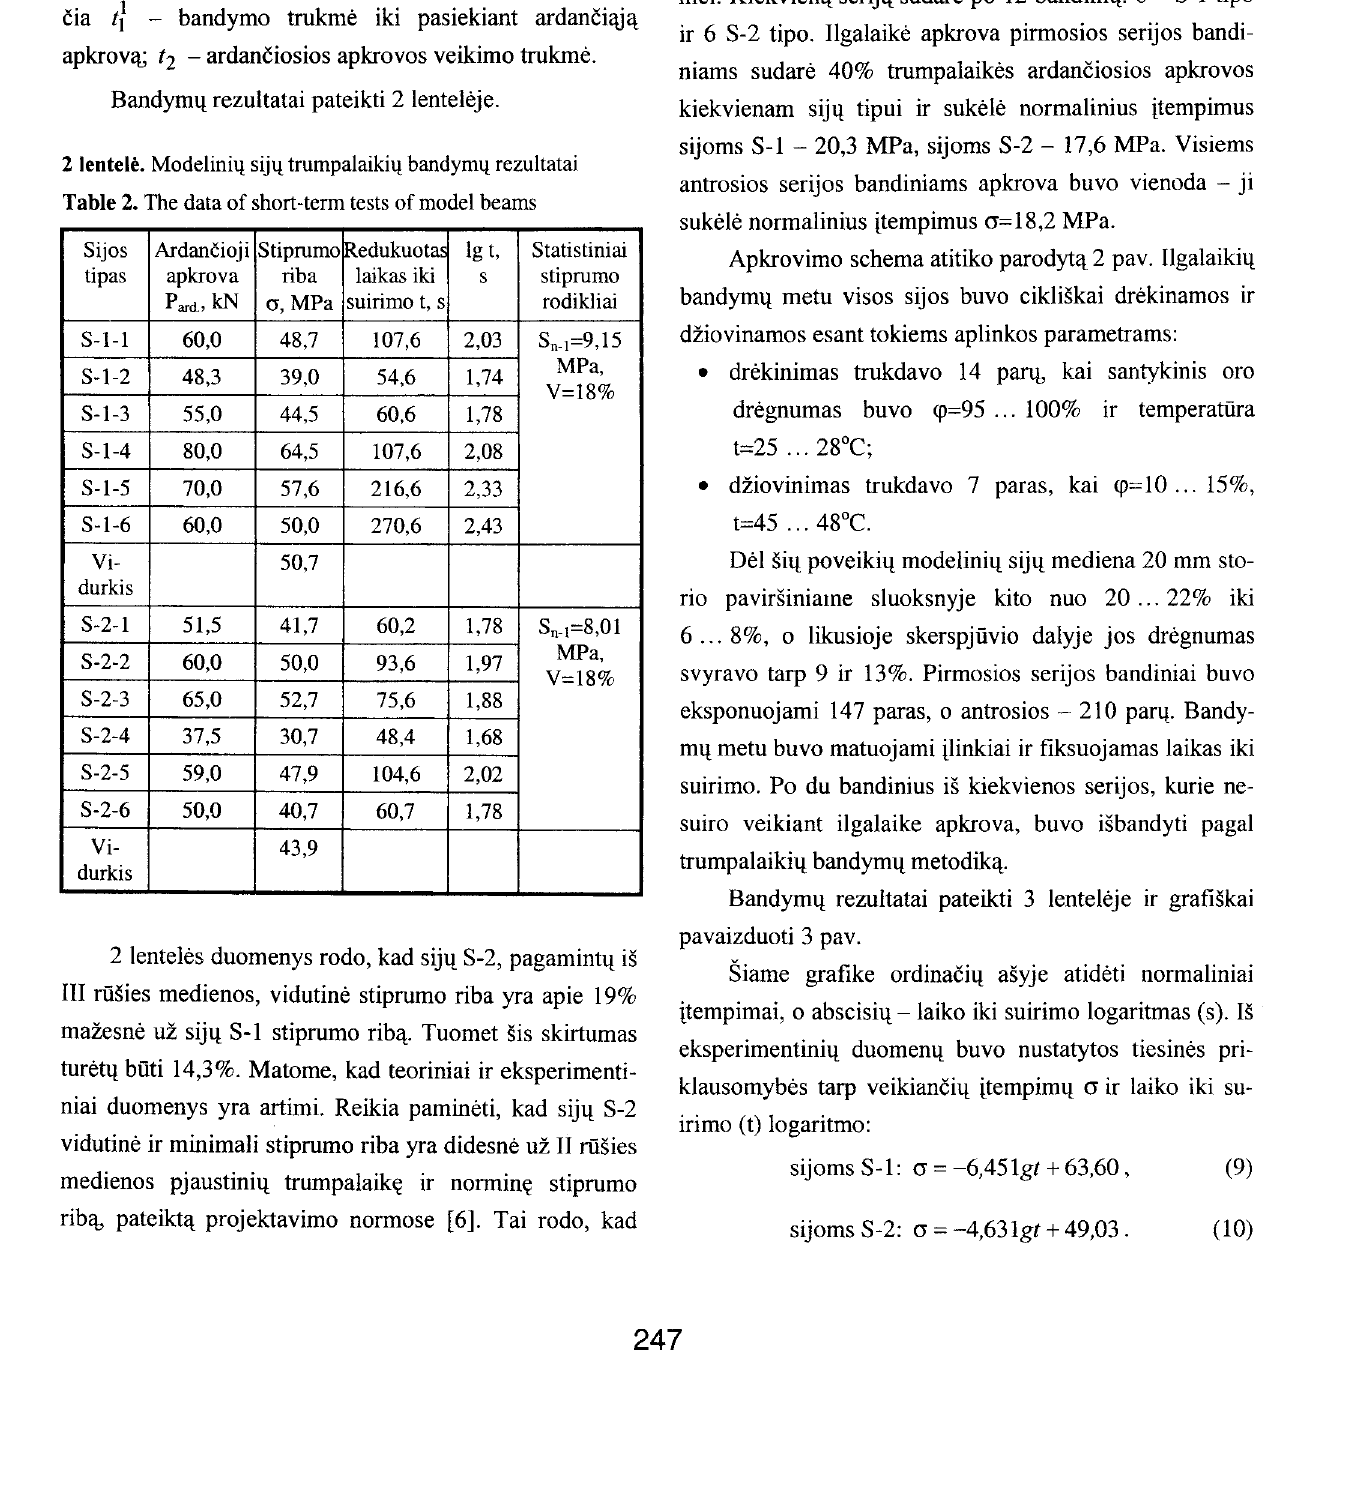
Table 2. The data of short -term tests of model beams